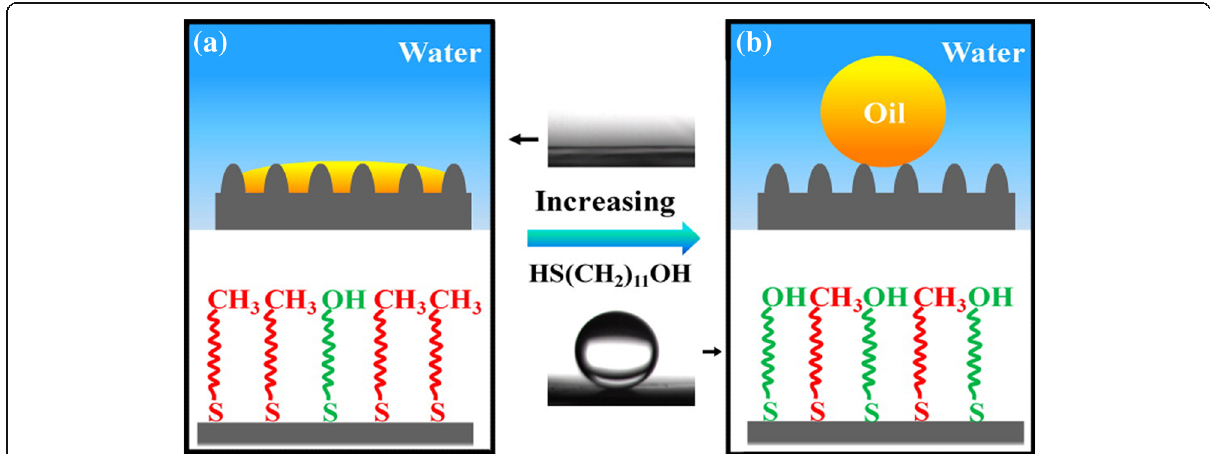
Fig. 11 Schematic illustration of underwater oil wettability on the obtained surfaces: for surfaces prepared with XOH ≤ 0.2, the surfaces are mainly covered by the hydrophobic and oleophilic methyl groups ; thus the oil droplet can enter into the microstructures, and the surface would show underwater superoleophilicity ( a ). For the surface prepared with XOH ≥ 0.6, the presence of many hydroxyl groups increases the